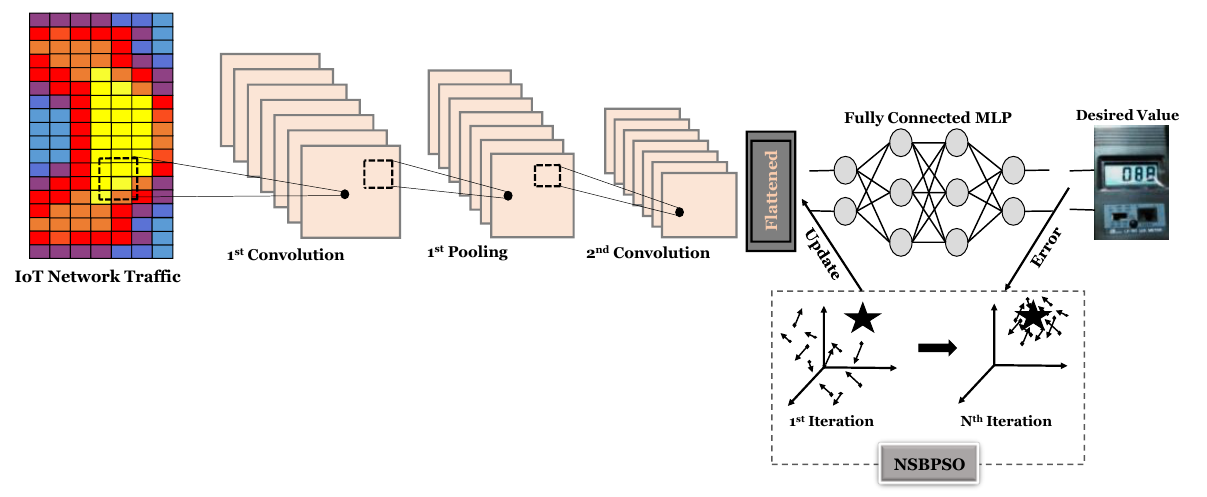
Figure 5. The overall schematic of the proposed model for detecting IoT network intrusions.